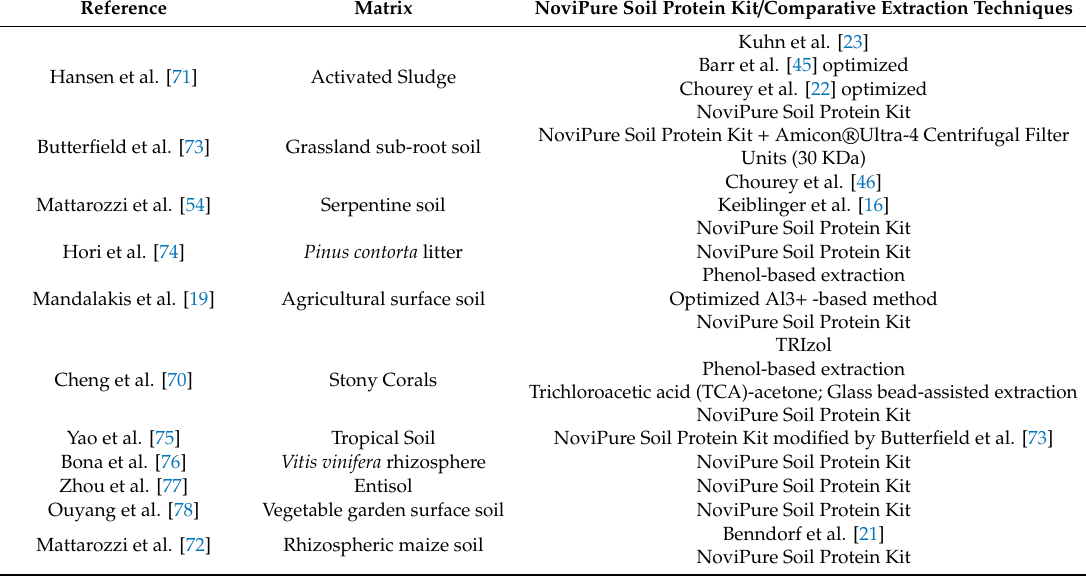
Table 1. Use of the NoviPure Soil Protein kit, comparison with other extraction techniques, and the starting